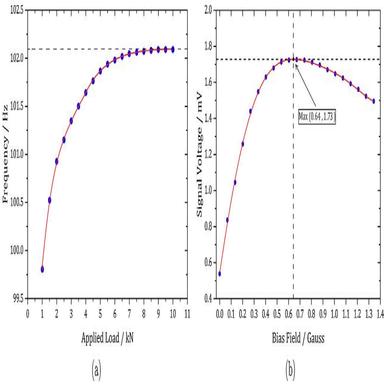
(a) Frequency dependence of the 2nd bending mode of the cantilever beam with the applied load at the fixed end, (b) change of the signal voltage of the 2nd bending mode versus the bias field.